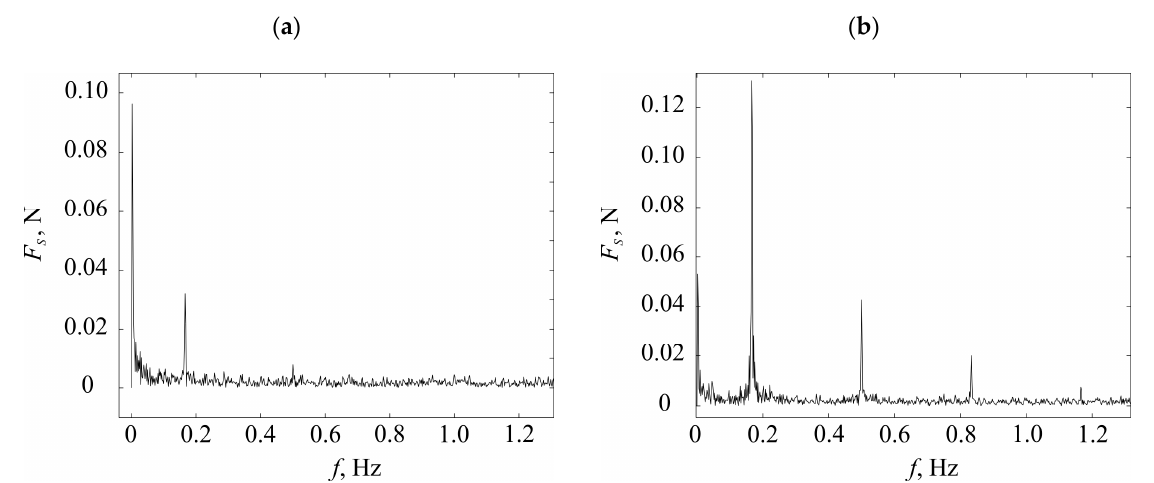
Figure 5. Discrete Fourier transform of the side force determined from the experiment: ( a ) for model A and ( b ) for model B.